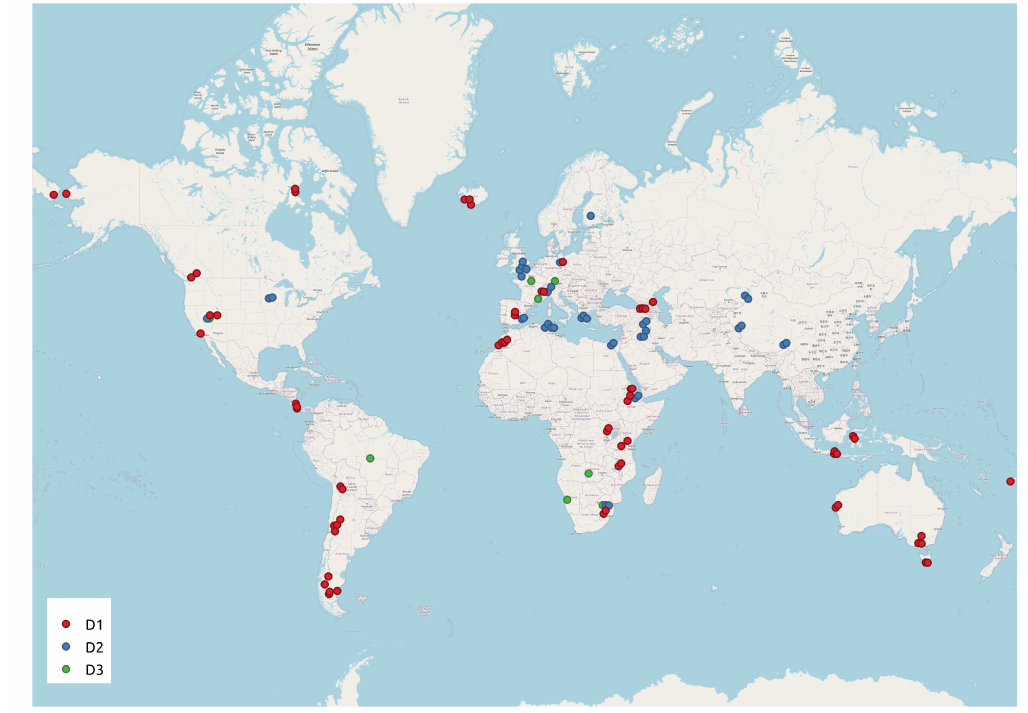
Figure 1. Global distribution of Sentinel-2 scenes included in the data sets used in this